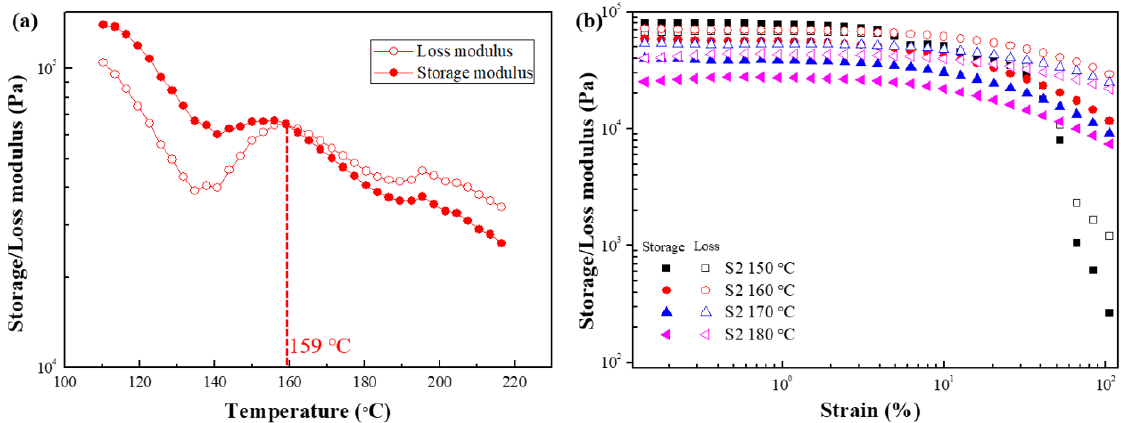
Figure 8. Storage (closed symbols) and loss (open symbols) modulus of ( a ) temperature sweep test and ( b ) strain amplitude sweep test for S2.